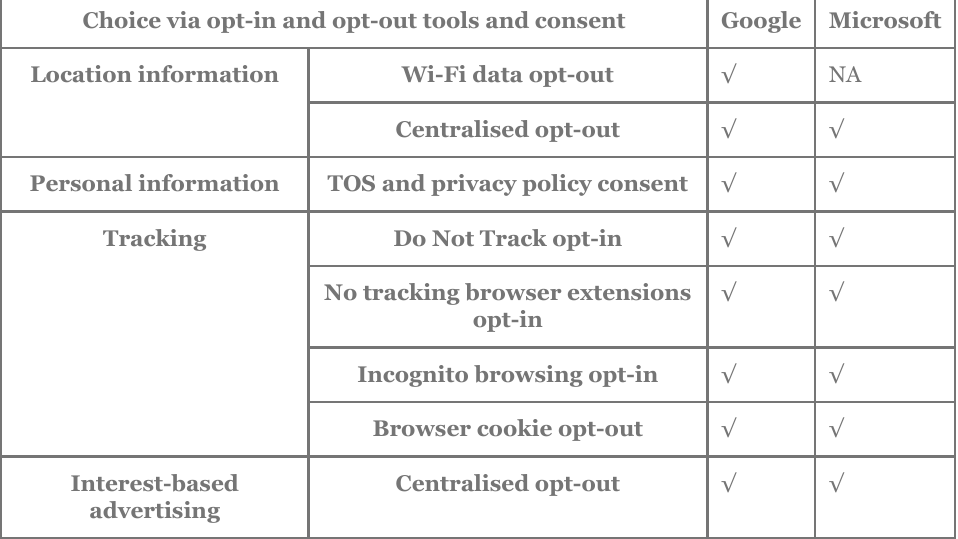
Table 1: Privacy choice by Google and Microsoft Choice via opt-in and opt-out tools and consent Google